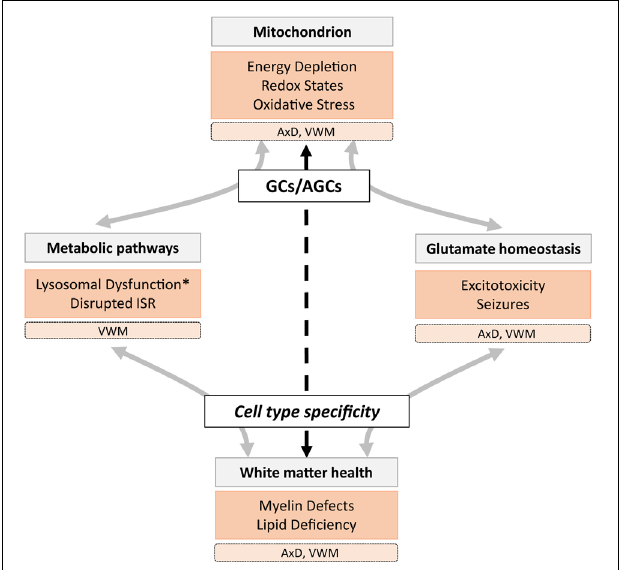
FIGURE 1 | A schematic overview of the role of mitochondrial glutamate carriers GCs and AGCs in metabolic and glutamate homeostasis mechanisms involved in healthy (gray) and pathological (orange) states associated with lysosomal storage diseases (LSDs), including the leukodystrophies AxD and VWM. We hypothesize that (A)GC (dys)function has cell- and region-specific effects (dashed arrow) that affect white matter health directly and indirectly. Pathological states marked with an asterisk are not observed in AxD and VWM, but are present in many